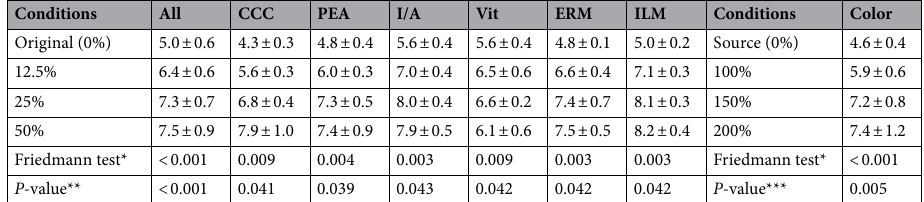
Table 1. Visibility scores of surgical images in ease of performing surgery by the vitreoretinal surgeons. CCC, continuous circular capsulorhexis; PEA, phacoemulcification and aspiration; I/A, irrigation and aspiration; Vit, vitrectomy; ERM, epiretinal membrane peeling; ILM, internal limiting membrane peeling; Color, color adjustments. *Friedmann test among 4 conditions, **Wilcoxon sign-rank test between the original and 12.5% intensity, ***Wilcoxon sign-rank test between 100 and 150% of color